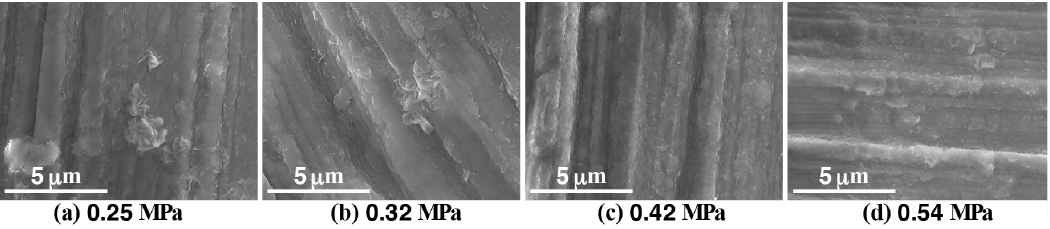
Figure 3. FE-SEM images of the films formed on AZ61 by steam coating under different conditions: ( a ) 0.25, ( b ) 0.32, ( c ) 0.42, and ( d ) 0.54 MPa. Table 2. Element concentrations of the anticorrosive film detected by EDX. Sample